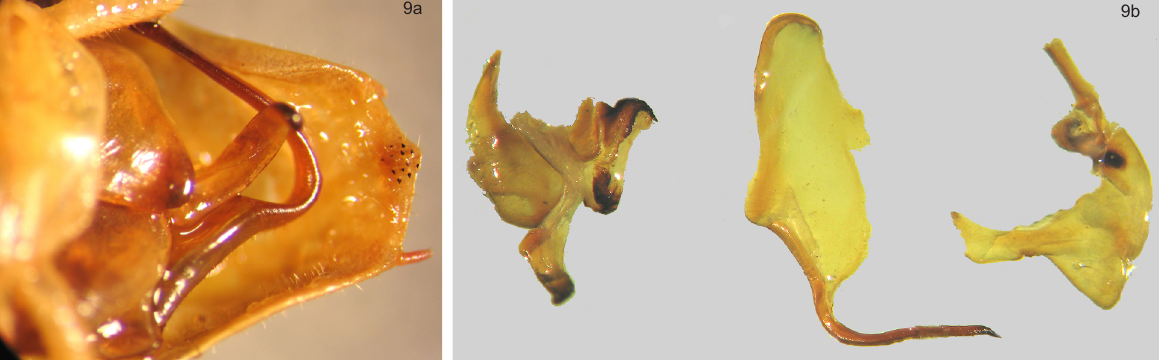
dark green. Abdominal segments: less broad, width